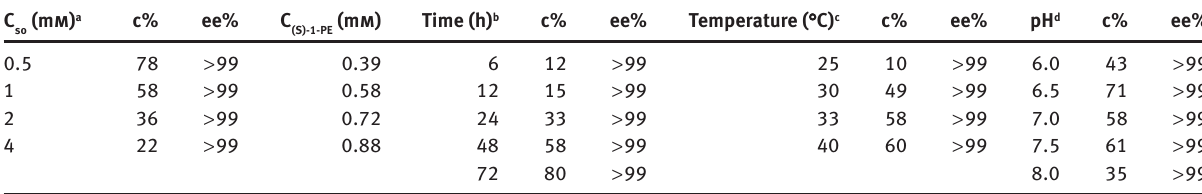
Table 1: The effect of independent model parameter on the c% and ee% values. C (mm) so